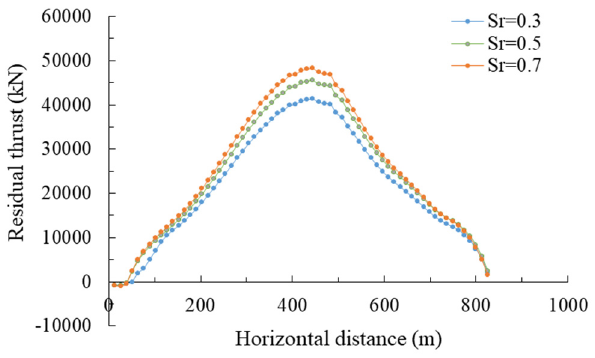
Figure 18. Diagram for distribution of residual thrust for different saturation degrees.